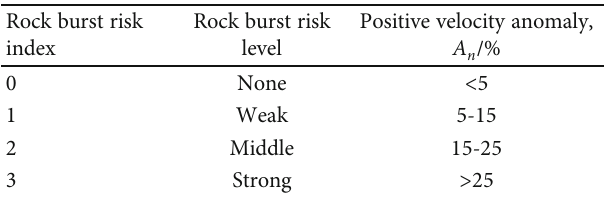
Table 1: Relation between positive velocity anomalies and rock burst risk